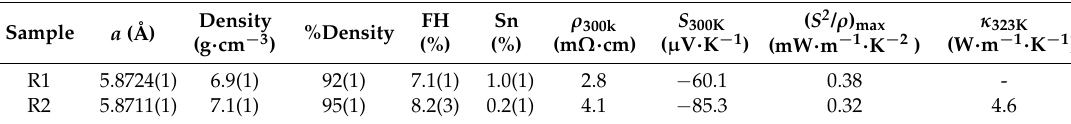
Table 1. Overview of the lattice parameters ( a ), sample densities, 300 K electrical resistivity ( ρ ) and Seebeck coefficient (S), maximum power factor ( S 2 / ρ ) max , and 323 K thermal conductivity ( κ ) for